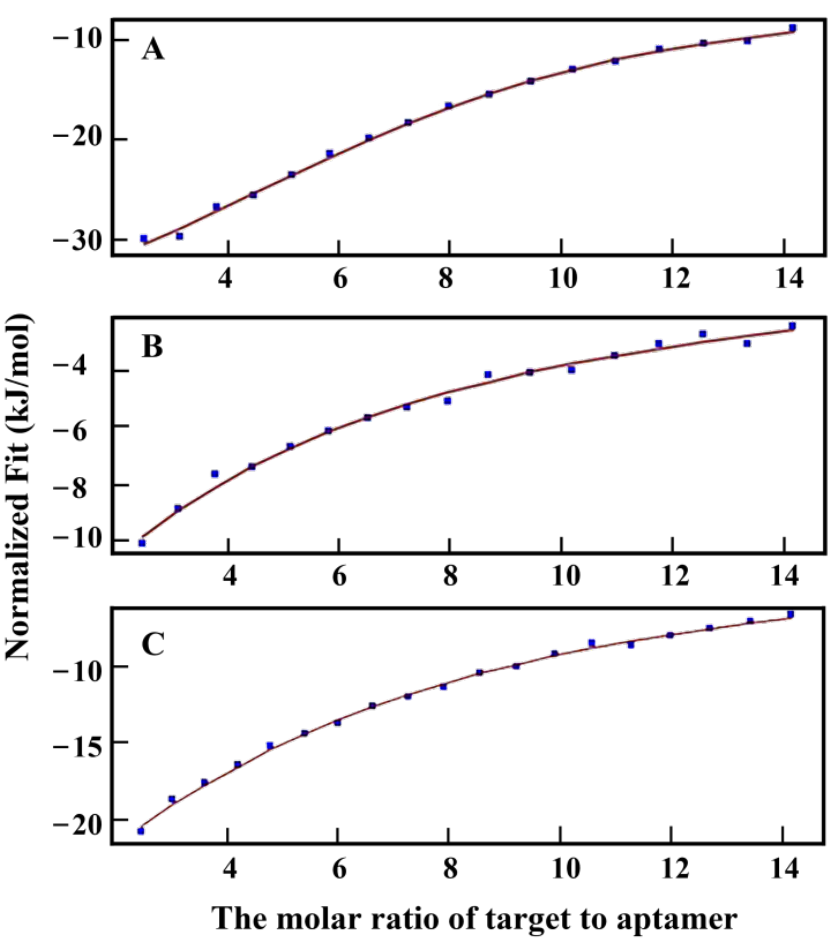
Figure 5. ITC analysis of ( A ) Thi-5R-18 ( B ) FAM-Thi13 ( C ) seq.20 with thiamethoxam.